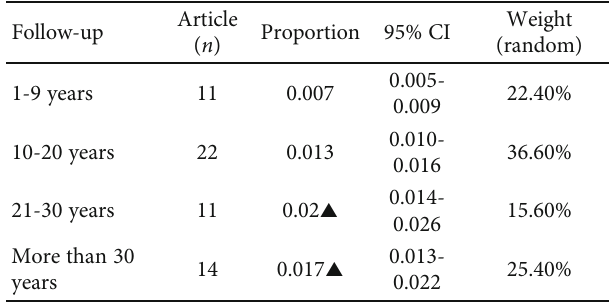
Table 4: Disease duration risk of CRC in UC patients.